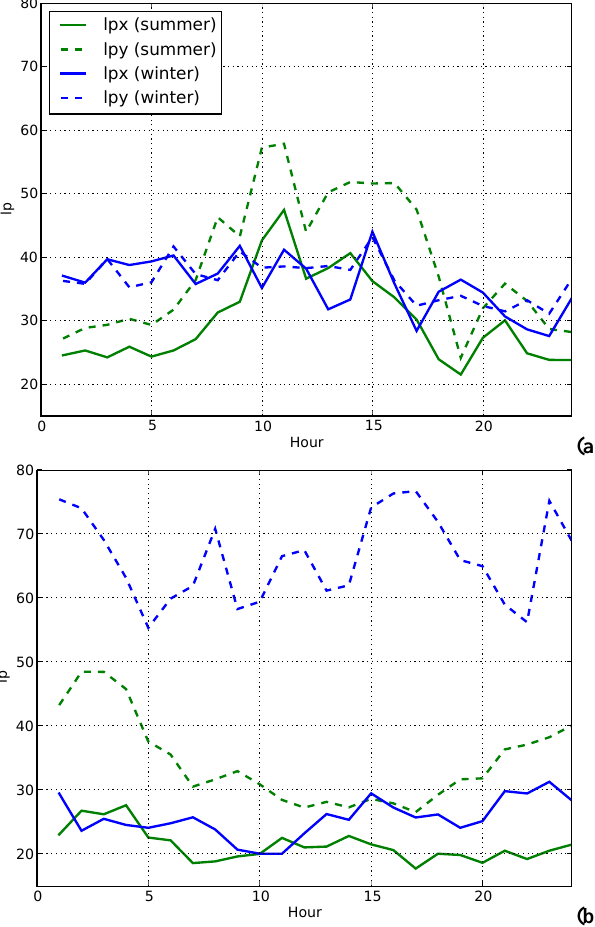
Fig. 5. Time series of estimated length-scales (in km) of the corre- lation of the forecast error, hourly-averaged in the period between 1 and 10 July 2010 and in the period between 1 and 10 Decem- ber 2010 in the grid cells of Paris (a) and Grenoble (b) ; lpx repre- sents the west–east length-scales and lpy represents the north–south